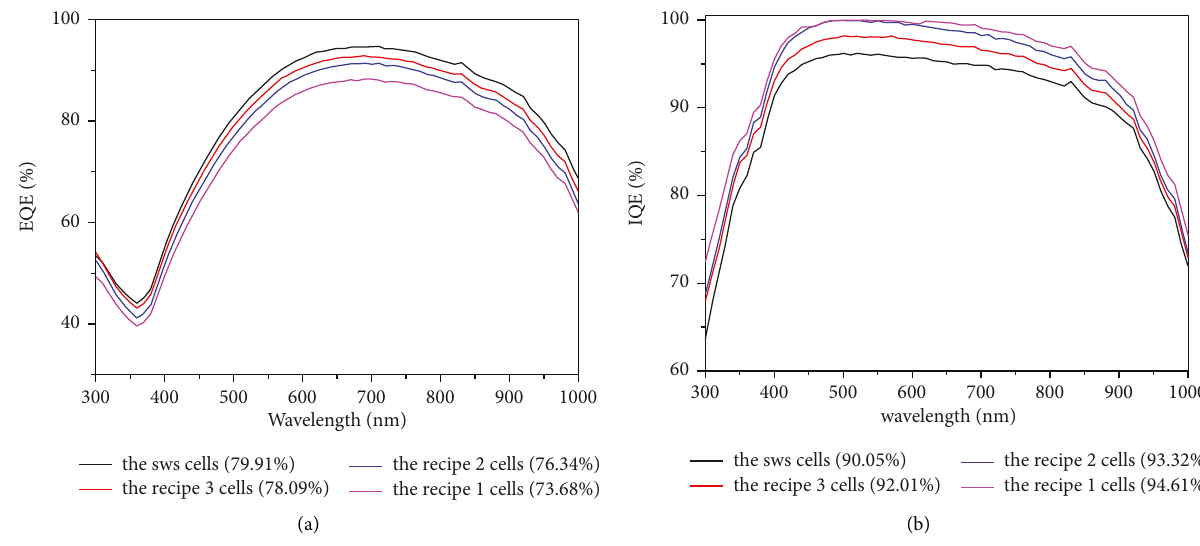
Figure 6: The EQE/IQE of the solar cells by the different texturing processes. (a) The EQE of the solar cells by the different texturing processes. (b) The IQE of the solar cells by the different texturing